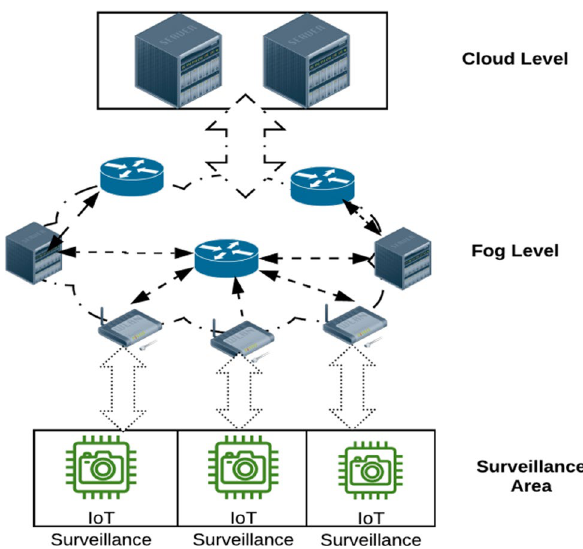
Fig. 4 The description of surveillance areas